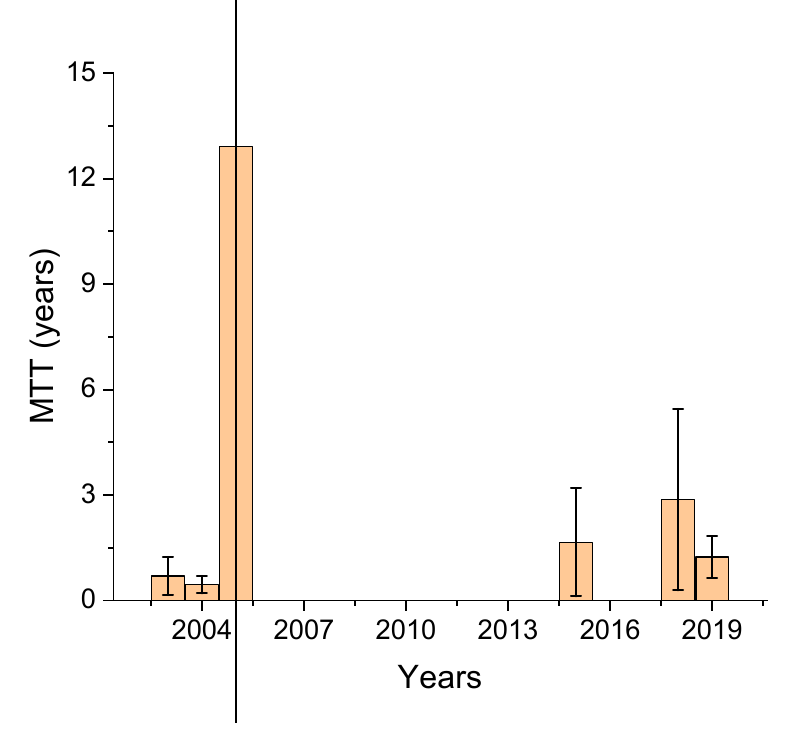
Figure 5. Mean transit time ( 𝜏̅ ).